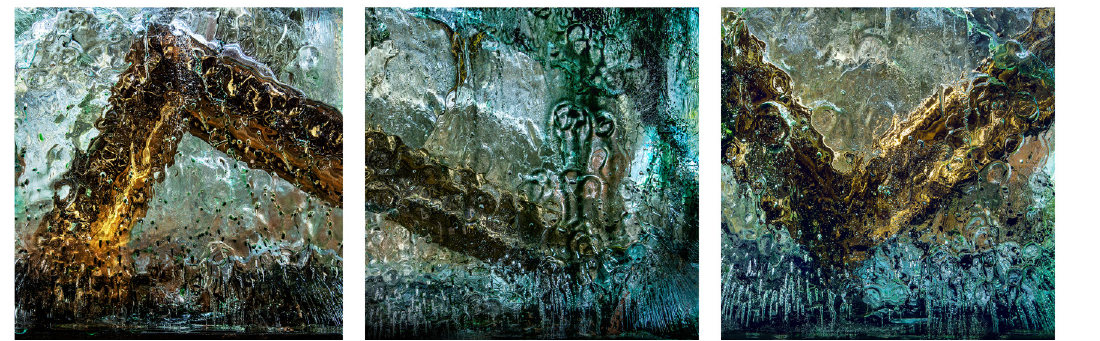
Figure 3 : Janet Tavener Janet Tavener, Broken Surface I-III , 2015, archival print on Canson Baryta, 90 x 90 cm. Courtesy: the artist and May Space,